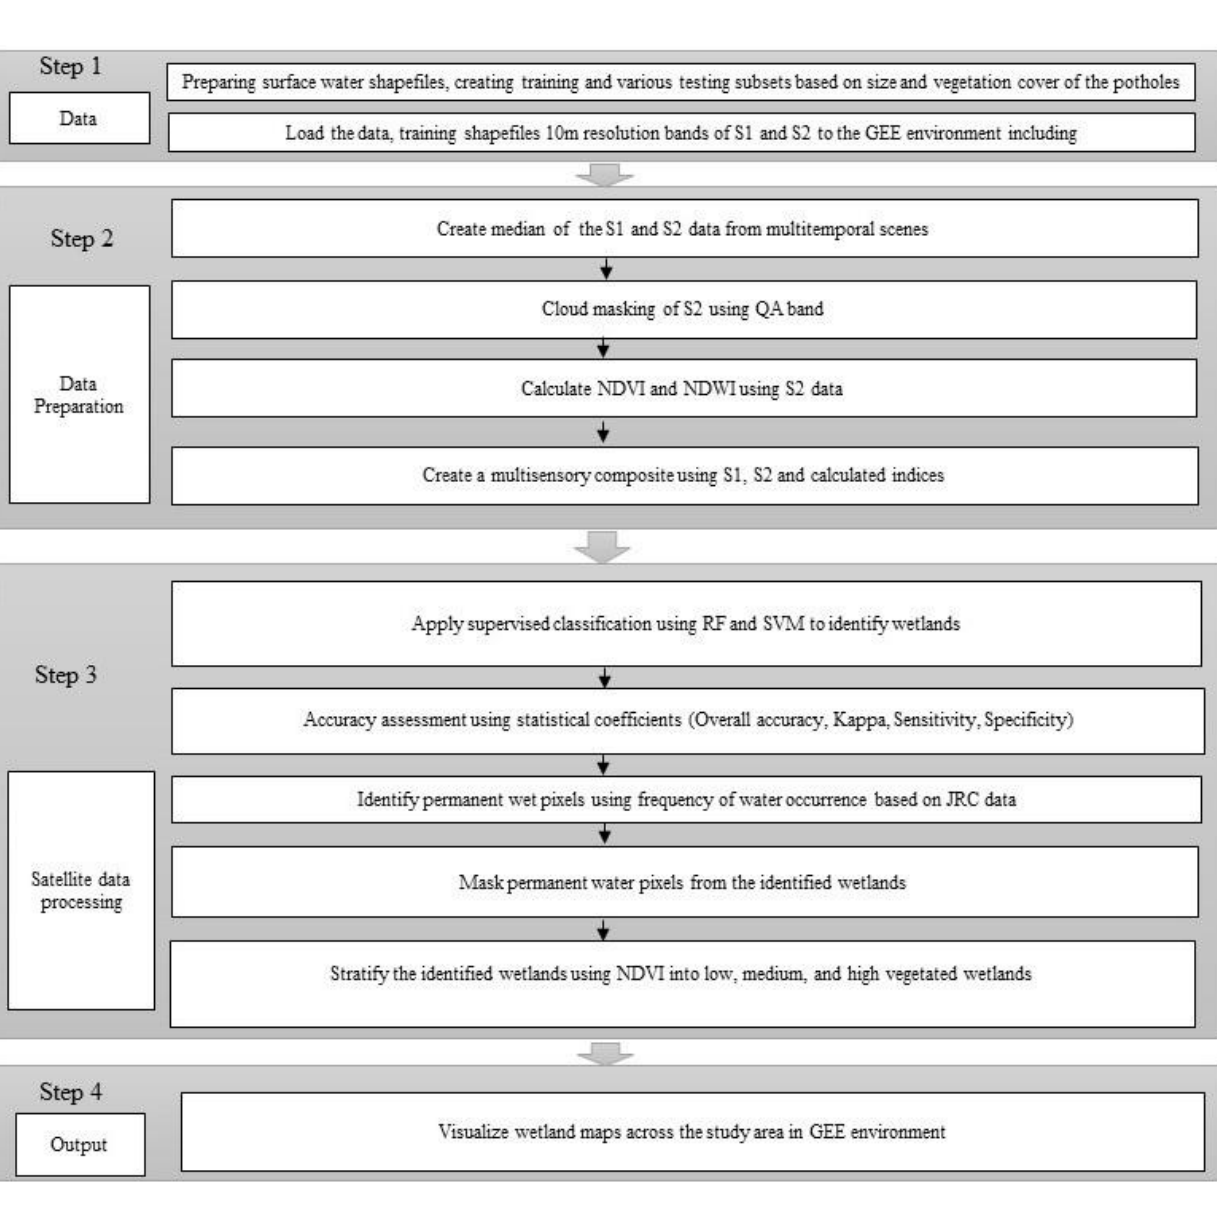
Figure 5. Flowchart showing the main steps that were used in this study for mapping wetlands surface